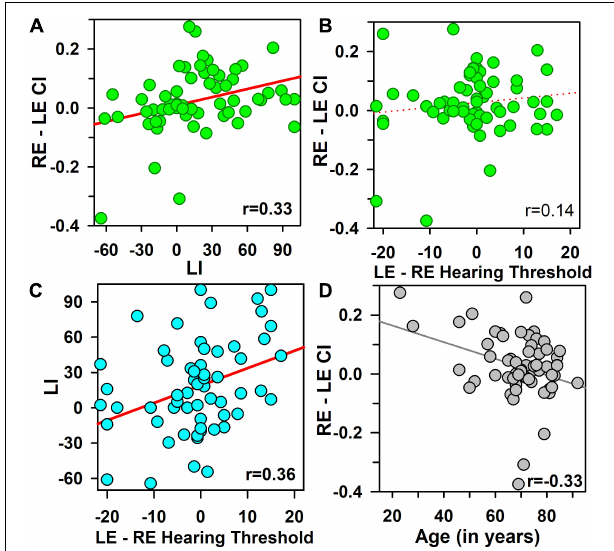
FIGURE 3 | Contextual influence asymmetry [calculated as the difference between right and left ears (RE–LE CI)], as a function of the laterality index [LI, obtained in a dichotic listening task, (A)] , and as a function of hearing threshold asymmetry [LE–RE hearing threshold, (B) ]. The Laterality index (LI) is shown as a function of hearing-threshold asymmetry (difference in hearing threshold between LE and RE), (C) . Contextual influence asymmetry (RE–LE CI) is shown as a function of age of participants in (D) . Pearson’s correlation coefficients are mentioned in each panel, and all coefficients greater than 0.30 (in bold fonts) are statistically significant ( p < 0.01, p adj <